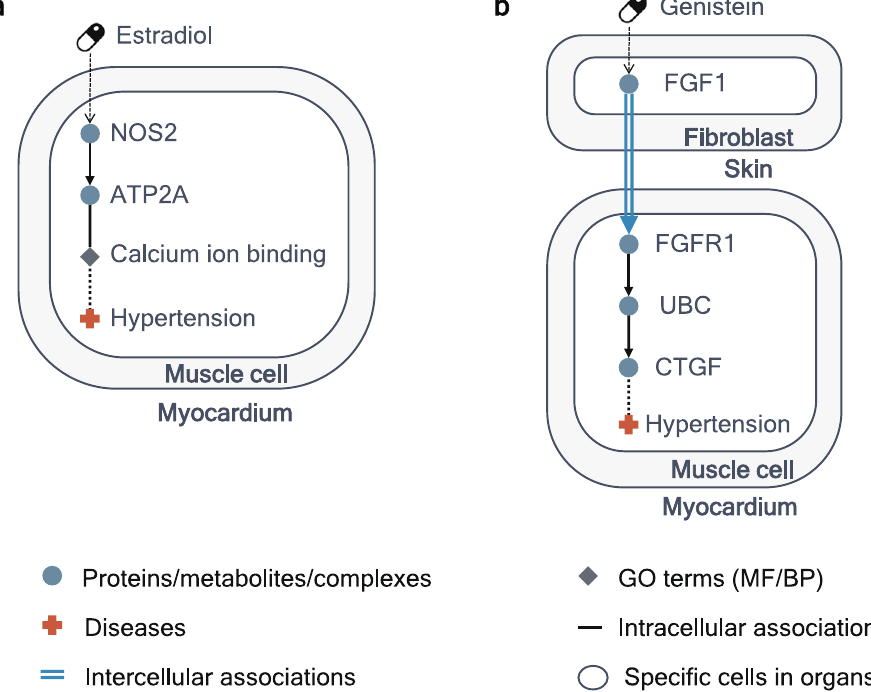
Figure 7. Inference of novel drug-disease associations by using CODA. ( a ) The path from estradiol to hypertension in muscle cell in myocardium in CODA. This path includes ‘calcium ion binding’, a molecular function, which is one of the novelties of CODA network. ( b ) The path from genistein to hypertension. Genistein affects FGF1 in fibroblast in skin at the first time and finally has effects on hypertension in muscle cell in myocardium through an intercellular association from FGF1 in fibroblast in skin to FGFR1 in muscle cell in